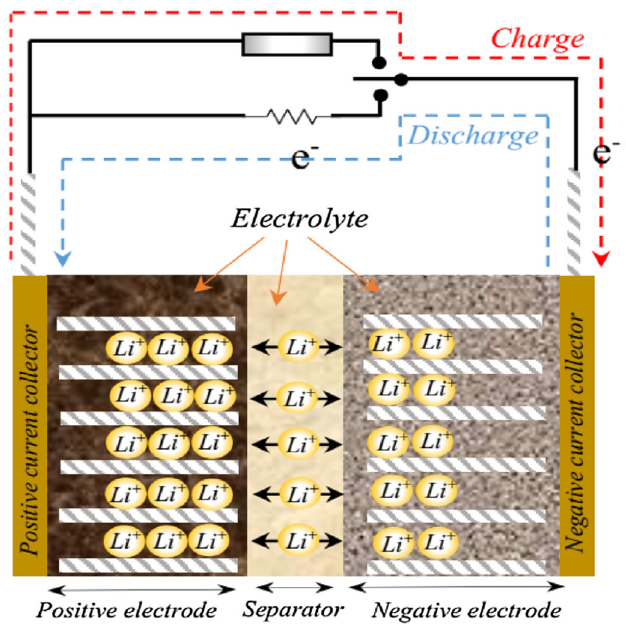
Figure 1. Schematic of a unit cell of the battery including positive and negative porous electrodes, a porous separator, and current collectors during the charge and discharge process [7].